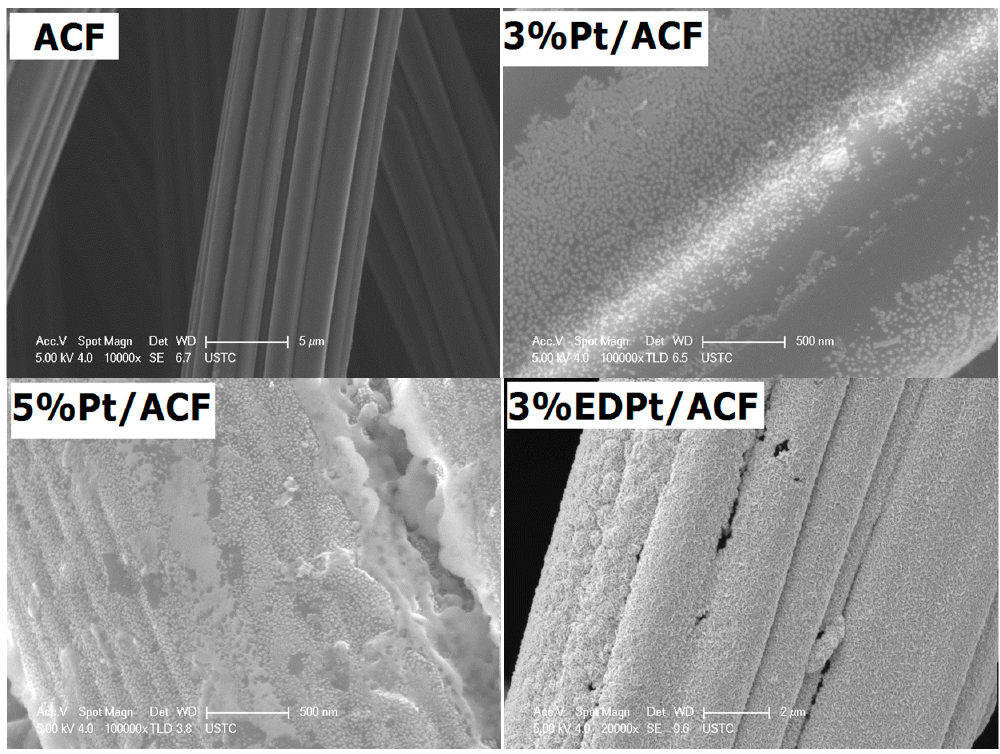
Figure 1. SEM images of the ACF, 3% Pt/ACF, 5% Pt/ACF and 3% EDPt/ACF electrodes. SEM: scanning electron microscopy; ACF: activated carbon fibers. Table 1. Structural parameters of blank ACF and the catalysts. Table 2. CO adsorption properties and dispersion of